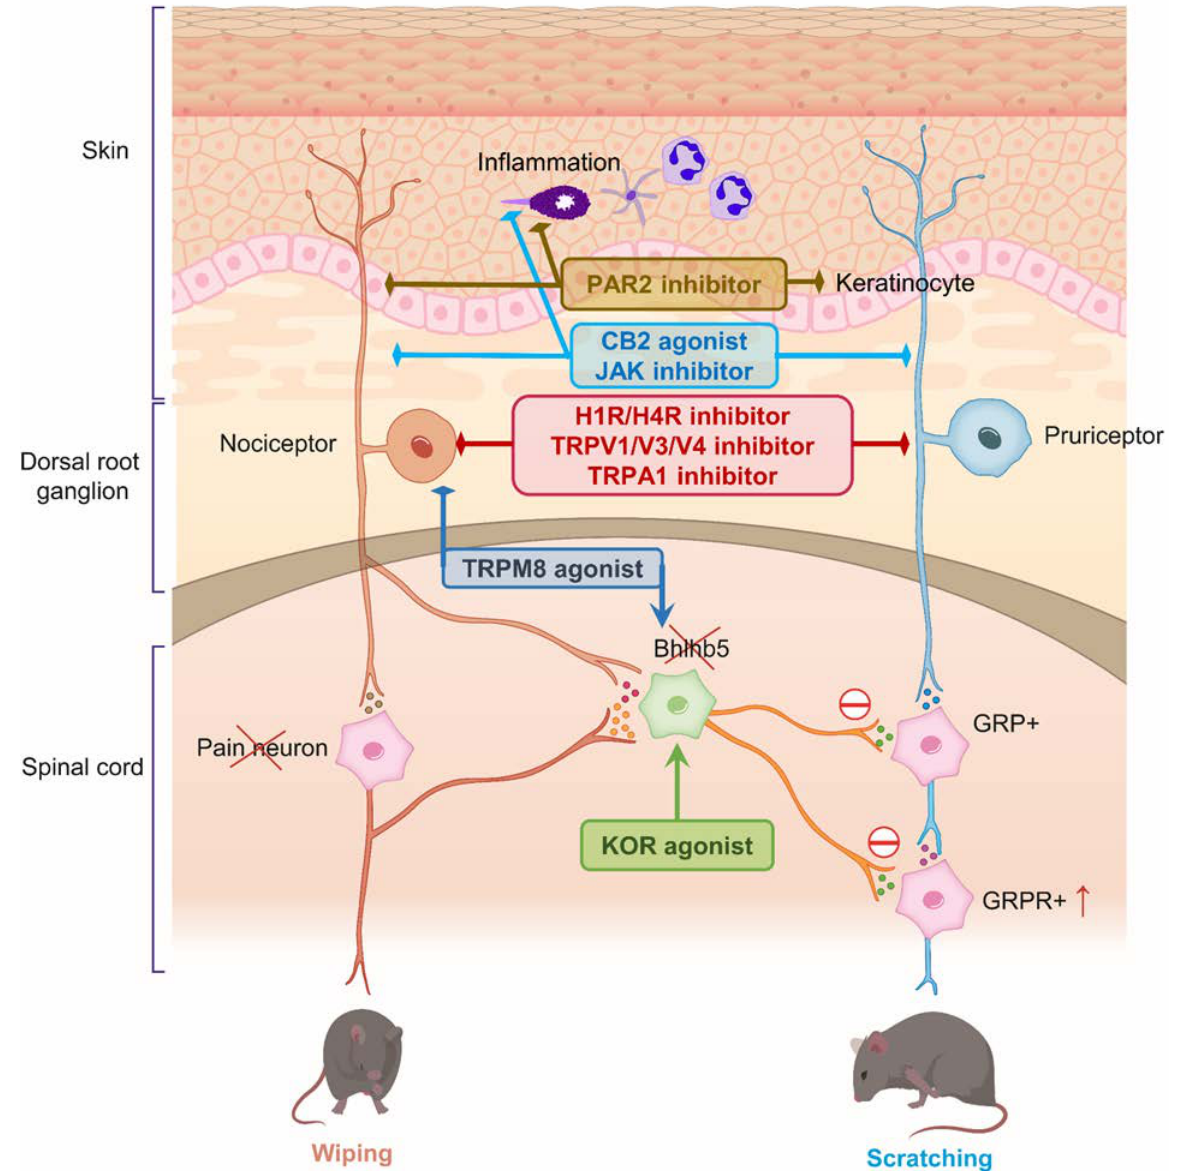
Figure 2. Interaction between pain and itch signaling in pathological (chronic) conditions relating to druggable targets with both antinociceptive and antipruritic effects. Multiple elements can contribute to the development of the mismatch and sensitization of chronic pain and itch in pathological conditions. (1) Afferents involved in pain and itch can be activated by either pruritogens or algogens, leading to the mismatched activation of pruriceptors or nociceptors, and partly account for peripheral sensitization. Moreover, central sensitization of spinal cord neurons is associated with (2) the upregulation of GRP and GRPR, and (3) reduction or loss of inhibitory control from Bhlhb5+ inhibitory neurons. Subsequently, these events disrupt the normal interaction between itch and pain. Arrow—activation; diamond—inhibition.